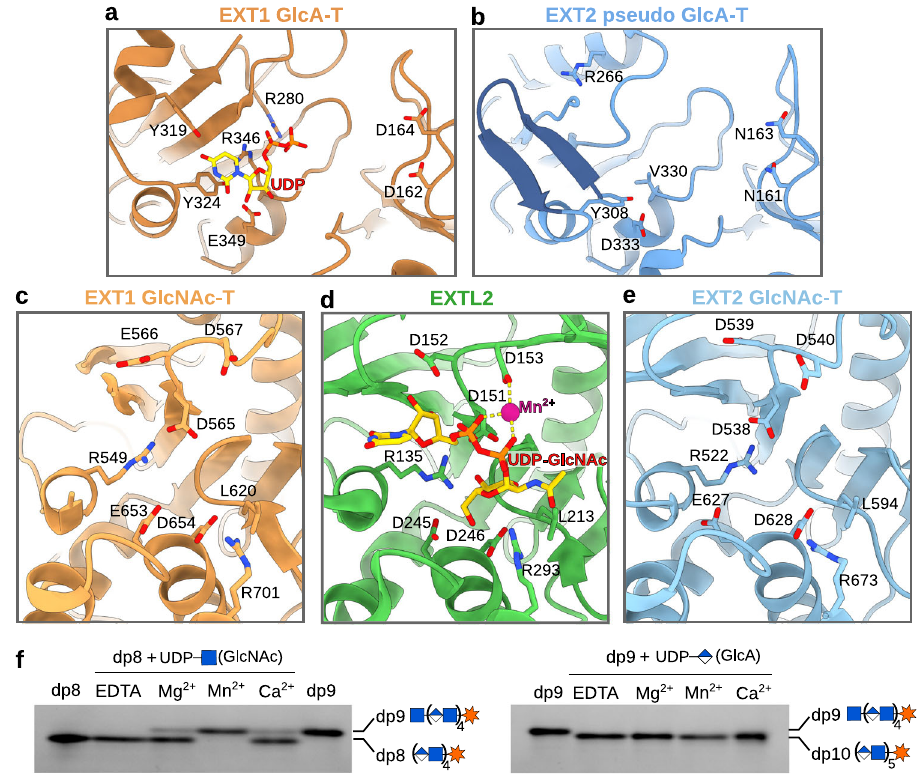
Fig. 3 | The active sites of the EXT1-EXT2 complex. a Cartoon representation of theEXT1GlcA-Tcatalyticsiteshownindarkorangewithimportantresiduesshown as sticks. b Catalytic site of the EXT2 pseudo-GlcA-T domain colored in dark blue and shown from the same view as in (a). Two anti-parallel beta-strands, colored in dark blue, intrude into the active site. c – e Cartoon representation of the GlcNAc-T activesitesofEXT1(lightorange),EXTL2(green),andEXT2(lightblue)withaUDP- GlcNAcdonorsubstrate(yellow)inthecrystalstructureofEXTL2(PDB-ID:1ON6) 14 .